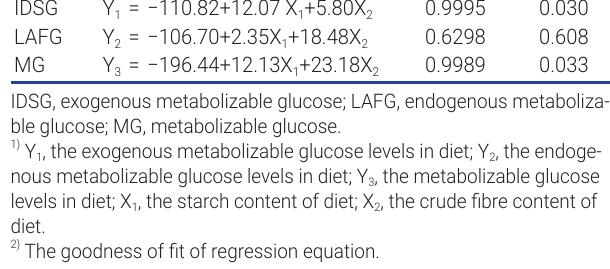
Table 6. The regression equation of three metabolizable glucose levels in diets and feedstuffs in Exp 1 Items Regression equation